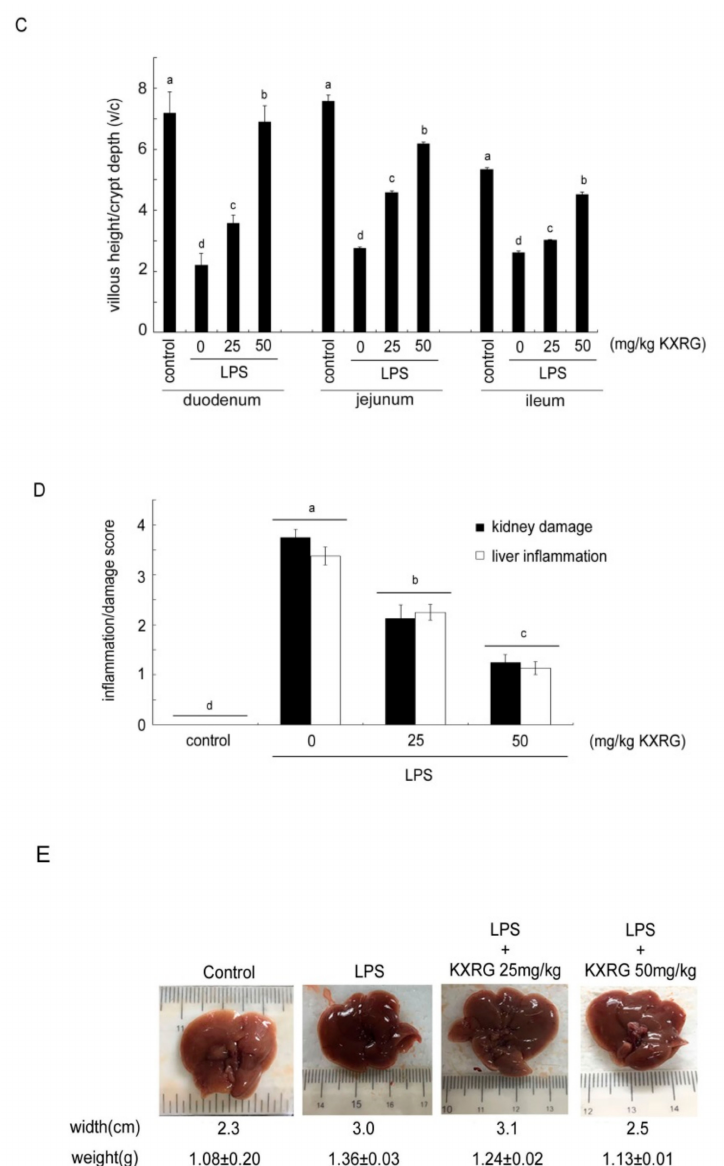
Figure 4. KXRG prevents LPS-induced systemic inflammation. Morphological changes in ( A ) the small intestine and ( B ) the kidneys and liver in controls and mice fed with 25 mg/kg or 50 mg/kg KXRG followed by LPS challenge. ( C ) Villous height/crypt depth in the duodenum, jejunum, and ileum of the different treatment groups. ( D ) Liver inflammation and kidney damage scores. ( E ) Liver weight of the mice with LPS treatment. Bars marked with different letters indicate statisti- cally significant differences among groups at p <